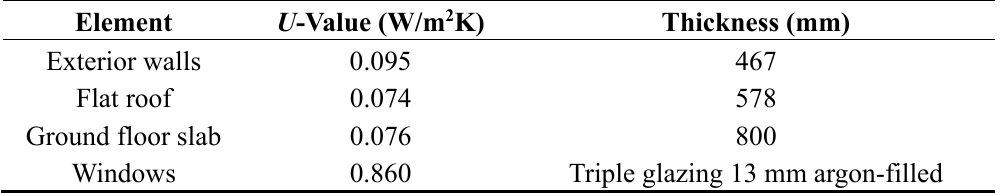
Table 3. U -Values used in the pilot study